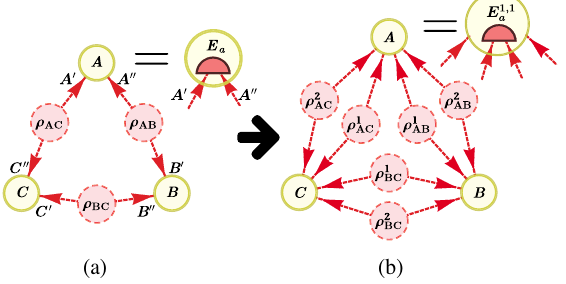
FIG. 4. Quantum inflation in the triangle scenario. (a) In the original scenario, by probing systems A 0 and A 00 with the quantum measurement f E a g a , a value a for the random variable A is generated. The values b and c for the random variables B and C are produced similarly. (b) In quantum inflation, we distribute n (in the case shown, n ¼ 2 ) independent copies of the same states to the parties, which now use the original measurement operators on different pairs of copies of the states they receive. For instance, the measurement operators f E 1 ; 1 a g a act on the states correspond- ing to copies ρ 1 AB and ρ 1 AC , and the measurements with other superindices are defined in an analogous